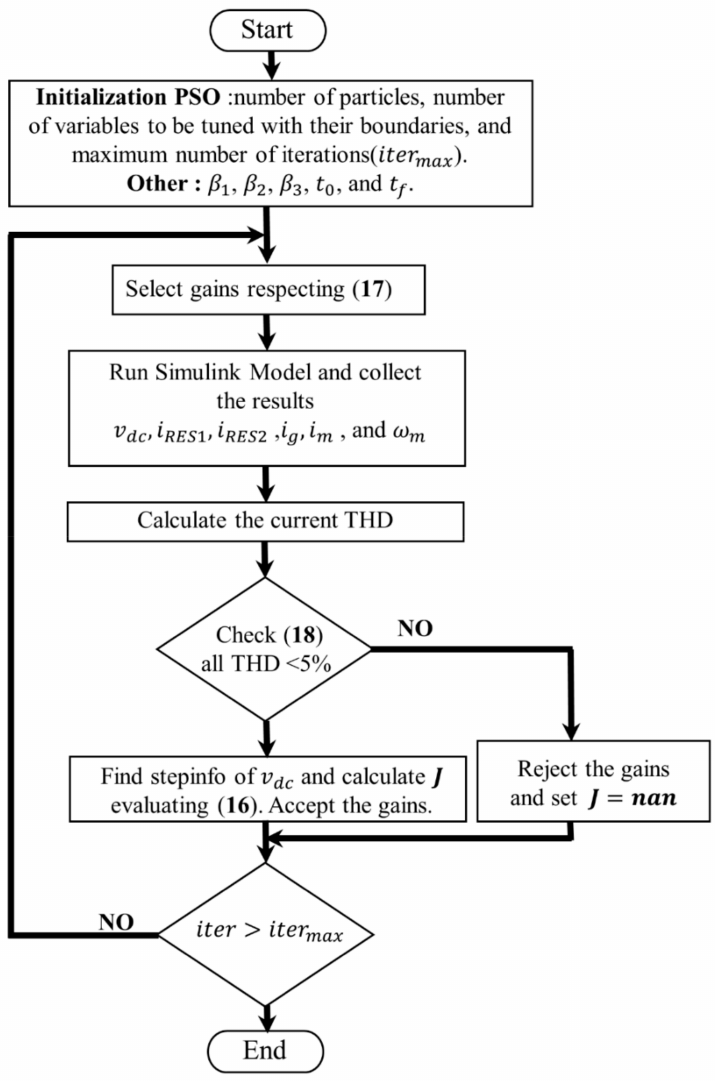
Figure 8. Flow chart of the proposed tuning procedure adopting